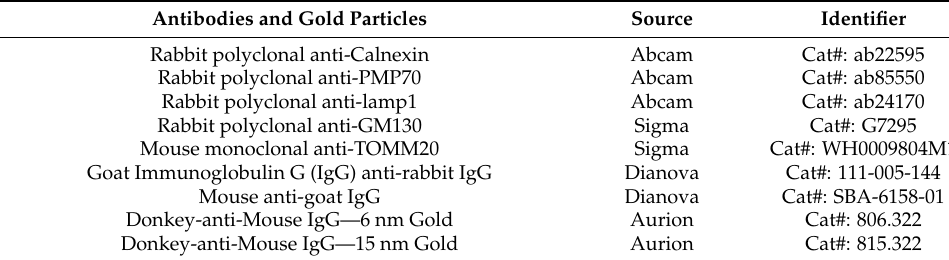
Table 2. Antibodies and gold particle materials